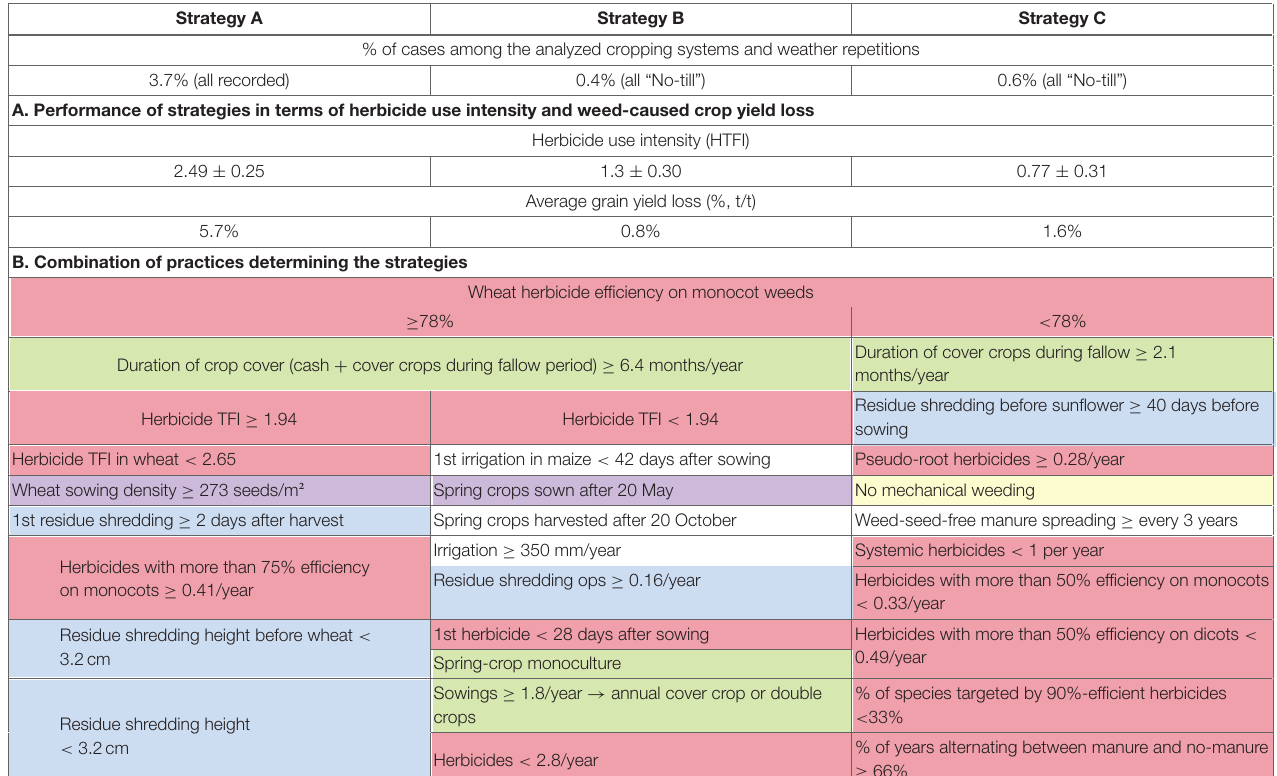
TABLE 5 | The three best strategies for limiting grain yield loss due to weed at the rotation scale (i.e., yield loss averaged over 30 simulated years) in no-till systems, based on a classification and regression tree on 466 systems × 10 weather repetitions (395 systems from the “No till” series, 2 × 36 no-till systems from the “recorded” and “herbicide-free”